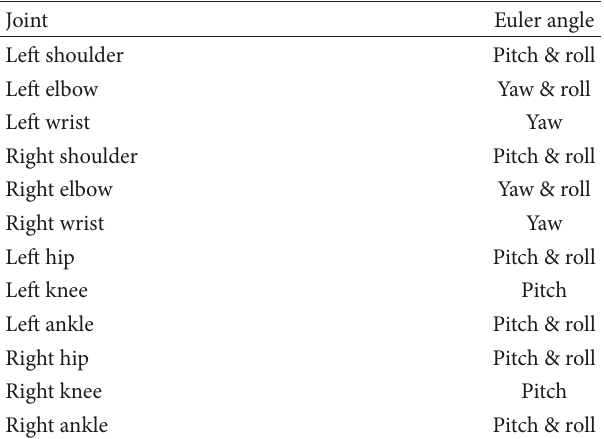
Table 1: The Euler angles of NAO simulator